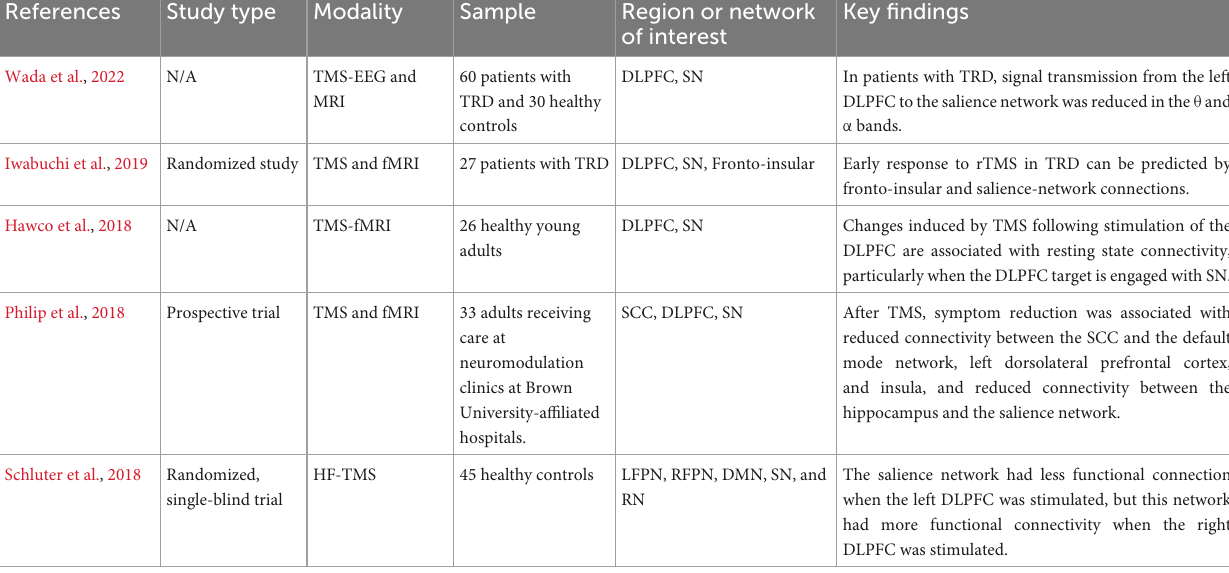
TABLE 3 Transcranial magnetic stimulation (TMS) studies focusing on salience